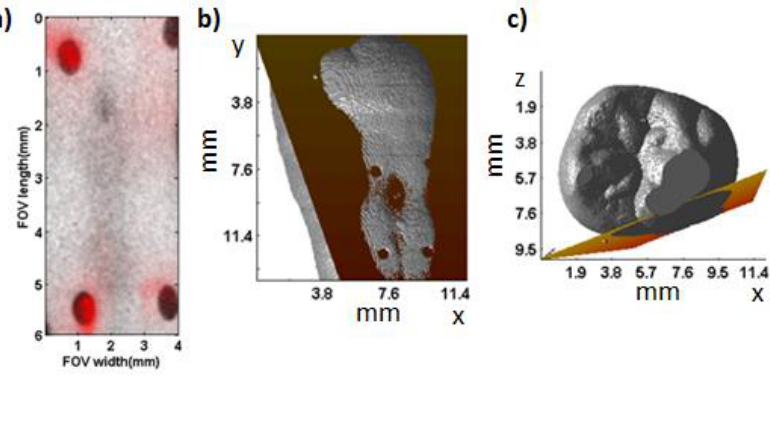
inclusion). ( b ) Side view of the same plane of tooth, showing alignment marks. ( c )